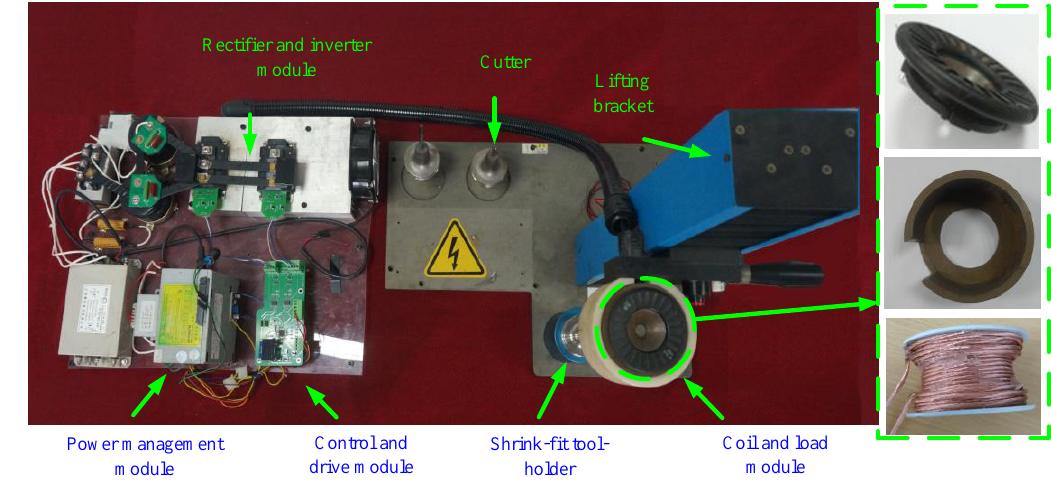
Figure 11. Tool holder heat-loading equipment.